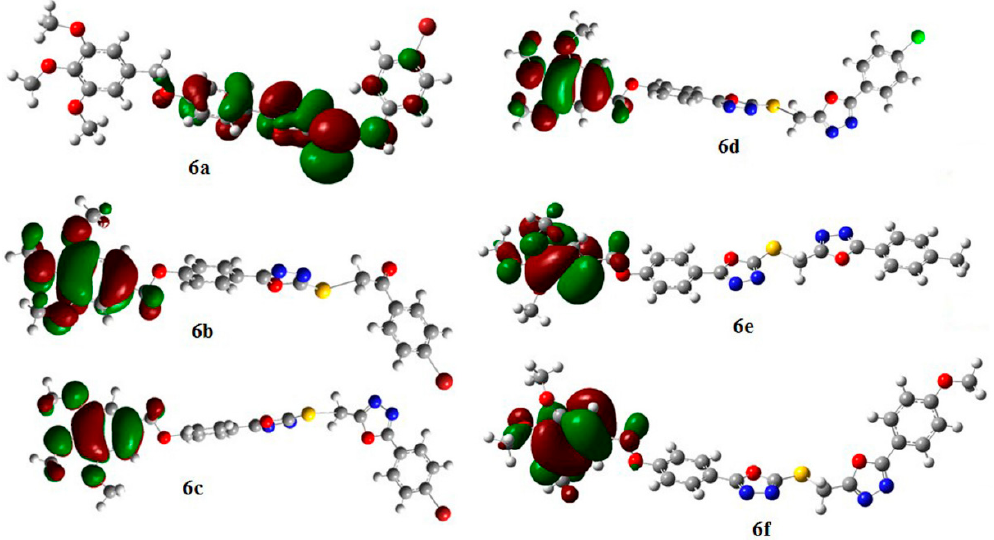
Figure 5. HOMO distribution for compounds 6a – f .